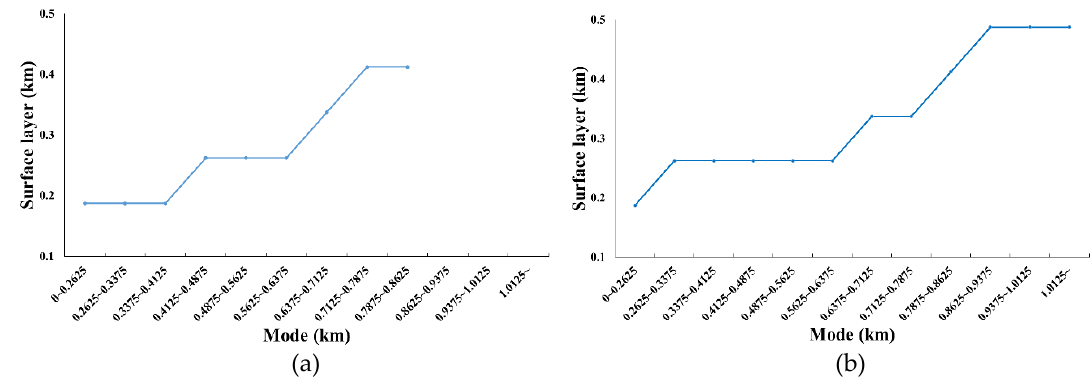
Figure 9. Determination of the height of surface layer along with the Mode for the cases where ( a ) Δh < 0.35 km and ( b ) Δh ≥ 0.35 km, respectively (i.e., Δh = PBLH − Mode ).